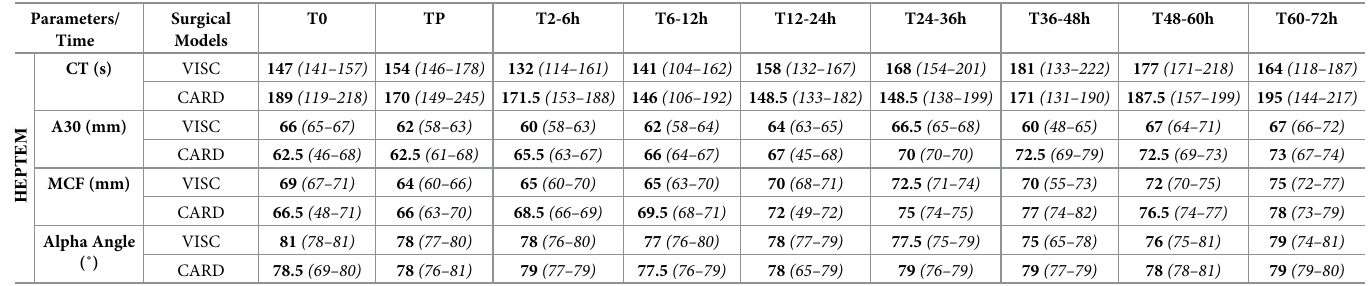
Table 2. ROTEM-HEPTEM parameters during anesthesia and the 72 h survival follow-up period (9 sampling times).